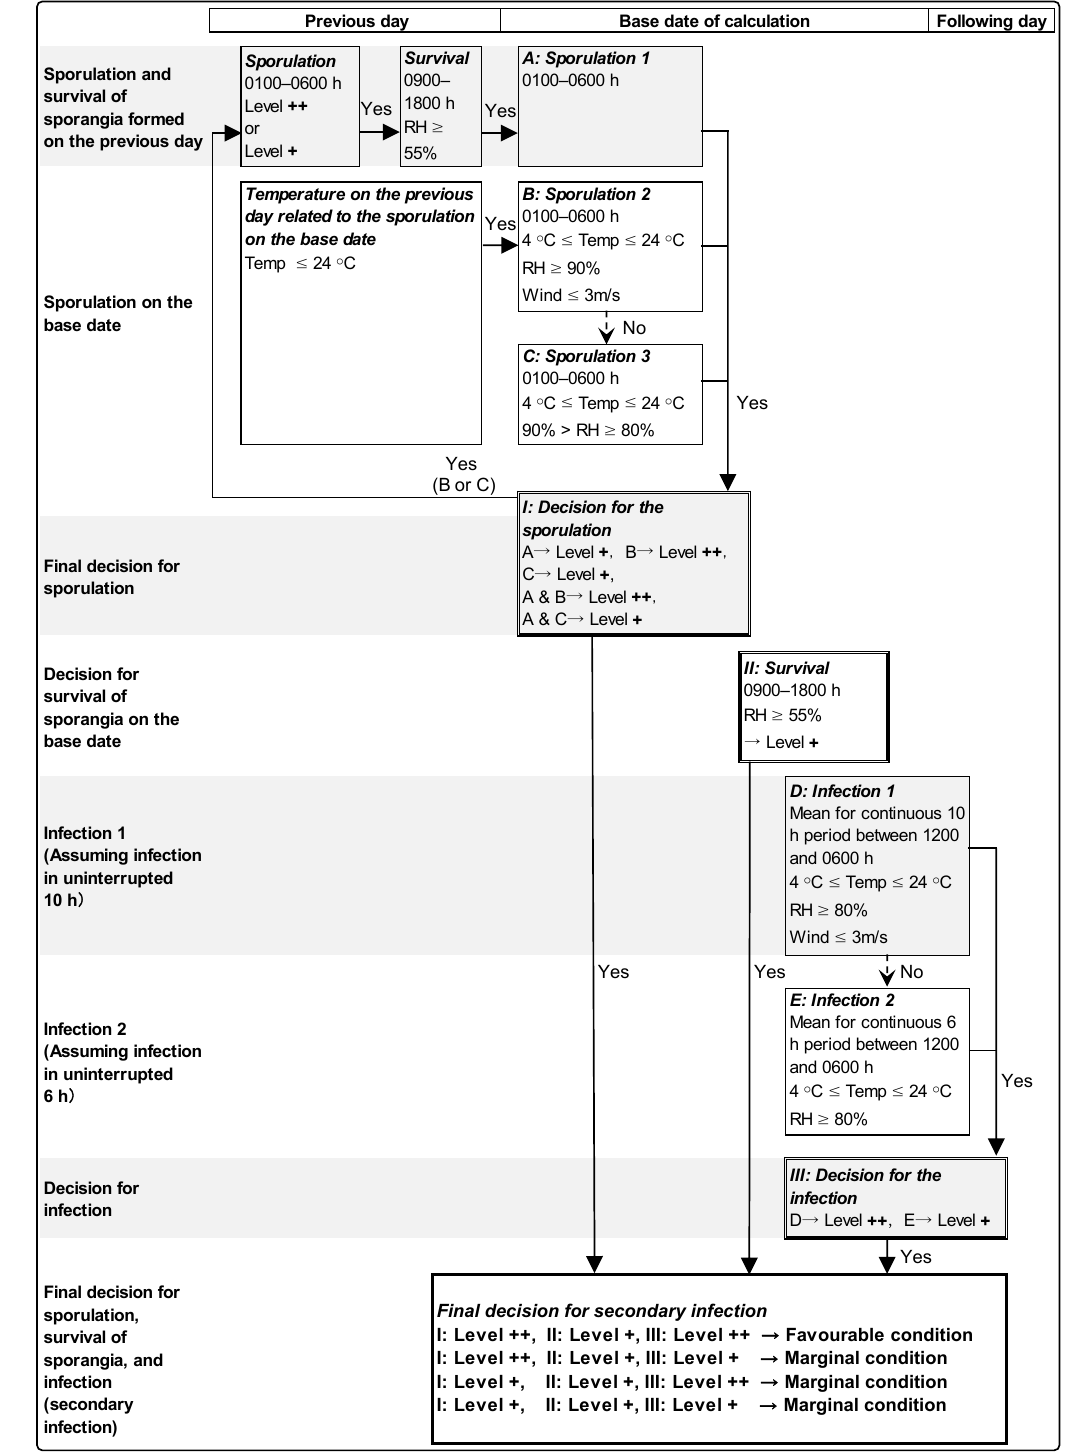
Figure 3. Criteria for estimating the date of occurrence of favourable meteorological conditions for secondary infection of onion downy mildew using the infection risk model. Air temperature (Temp), relative humidity (RH), and wind speed (Wind) are hourly data.